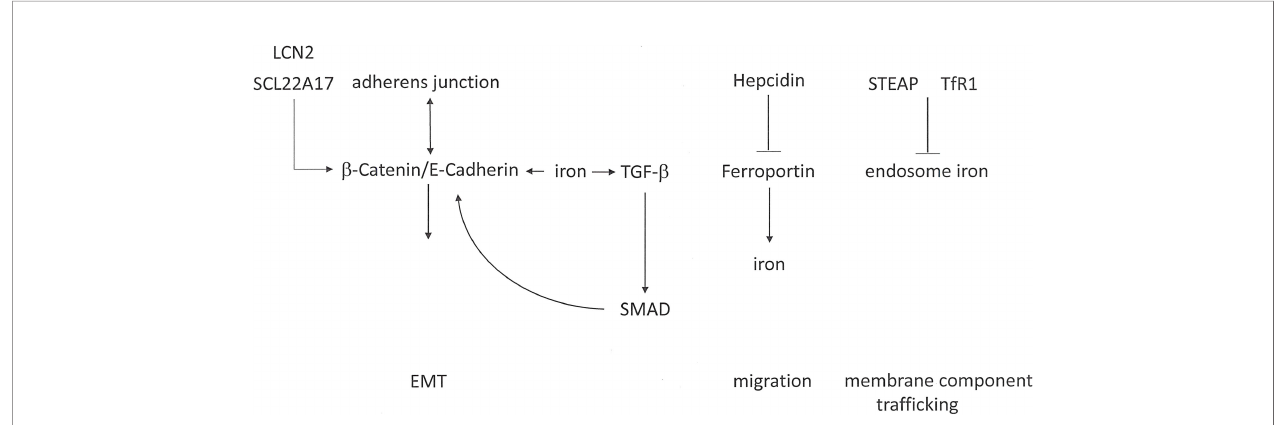
FIGURE 4 | Iron signaling in cancer metastasis. Iron plays complex roles in epithelial-mesenchymal transition (EMT), cell migration, and membrane component traf fi